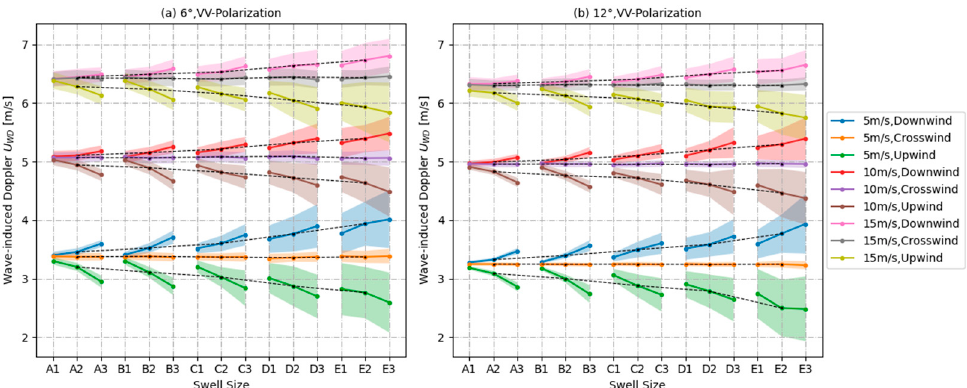
Figure 19. Wind speeds of 5, 10, and 15 m/s. Different swell scale in different wind directions when the contribution to the U WD ; the horizontal coordinate swell scale corresponds to the swell scale defined in Table 1; colored solid line segment plotted the same wavelength; the effective wave height increases the contribution to the U WD , corresponding to the color shading for the standard deviation of the data; black dashed line is connected to the approximate equal scaling of the swell.